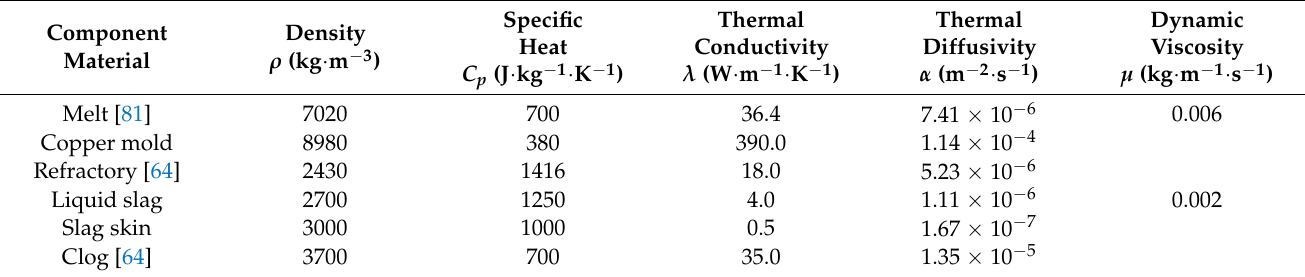
Table 1. Material